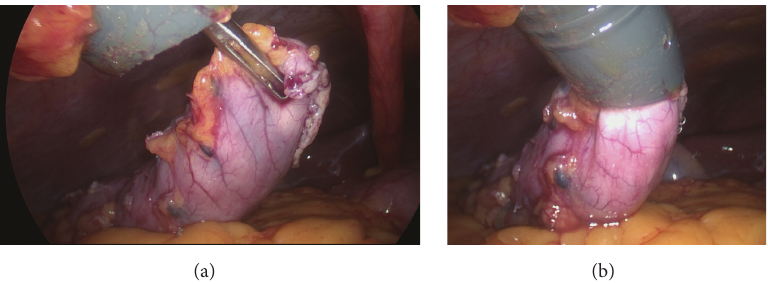
Figure 1: Intraoperative view of specimen grasping (a) and pulling into the 15 mm trocar for extracting (b).